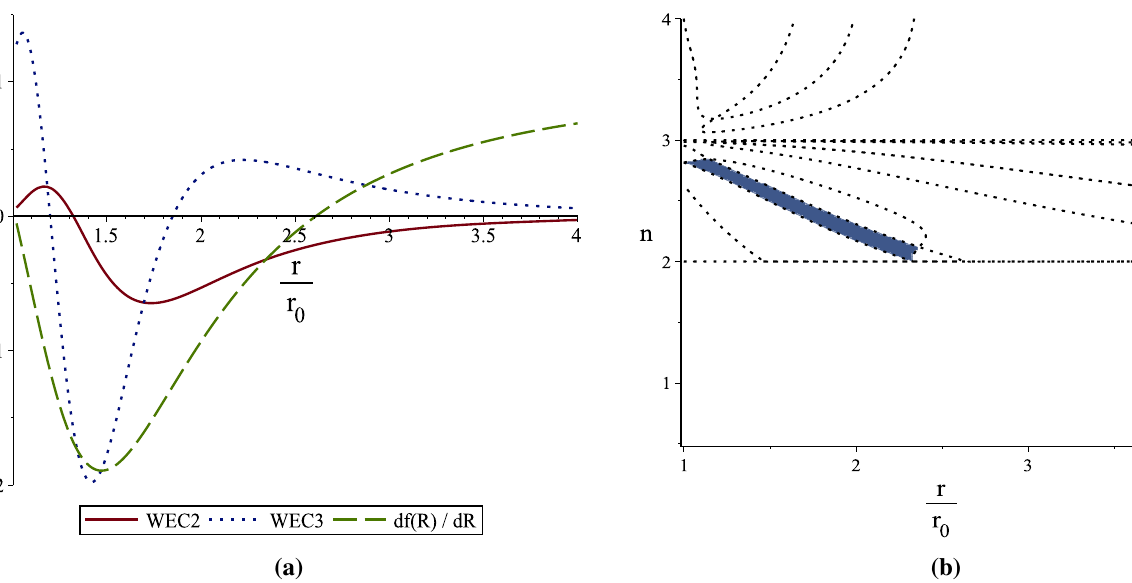
Fig. 5 a Shows that df ( R )/ dR < 0 and the NEC is satisfied at the